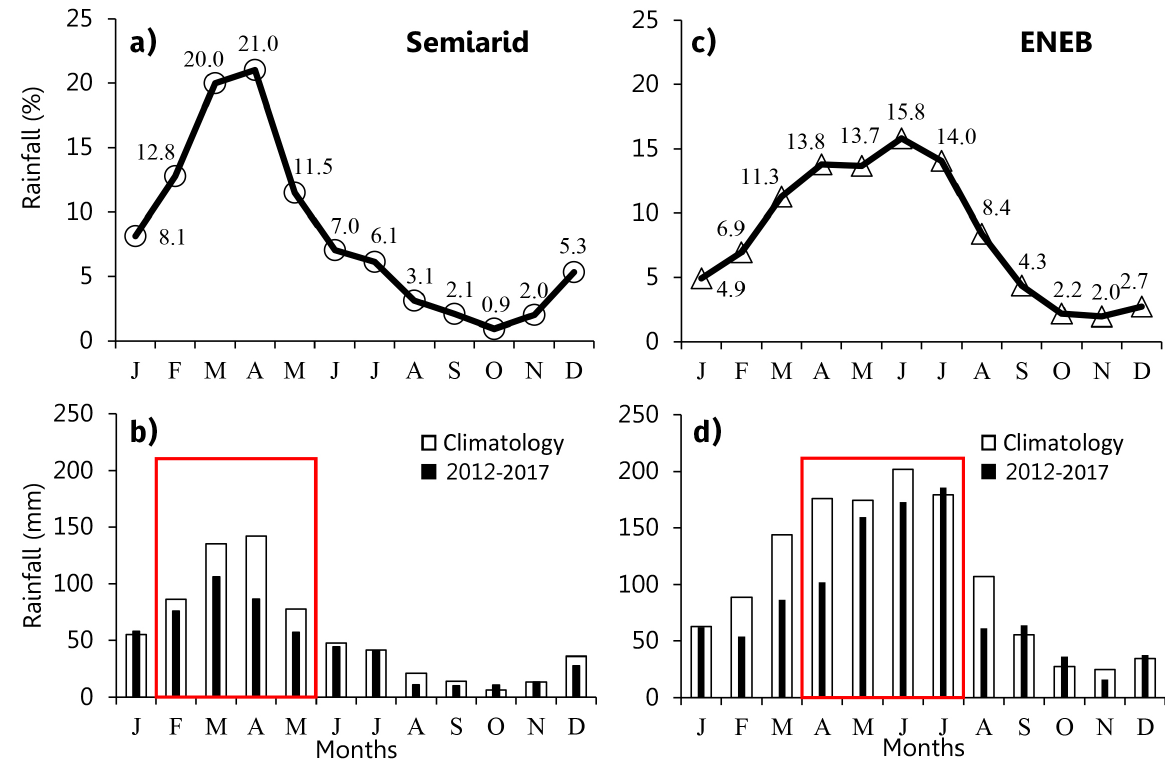
Figure 2. Monthly concentration of precipitation extracted from the GPCP satellite database in the climatological period (1981-2010) in the northern semiarid region a and east coast of Northeast Brazil b ; and comparison between average monthly rainfall in the 1981-2010 and 2012-2017 periods (mm), with highlight on the rainy seasons of the northern semiarid region (FMAM) c and east coast of Northeast Brazil (AMJJ) d